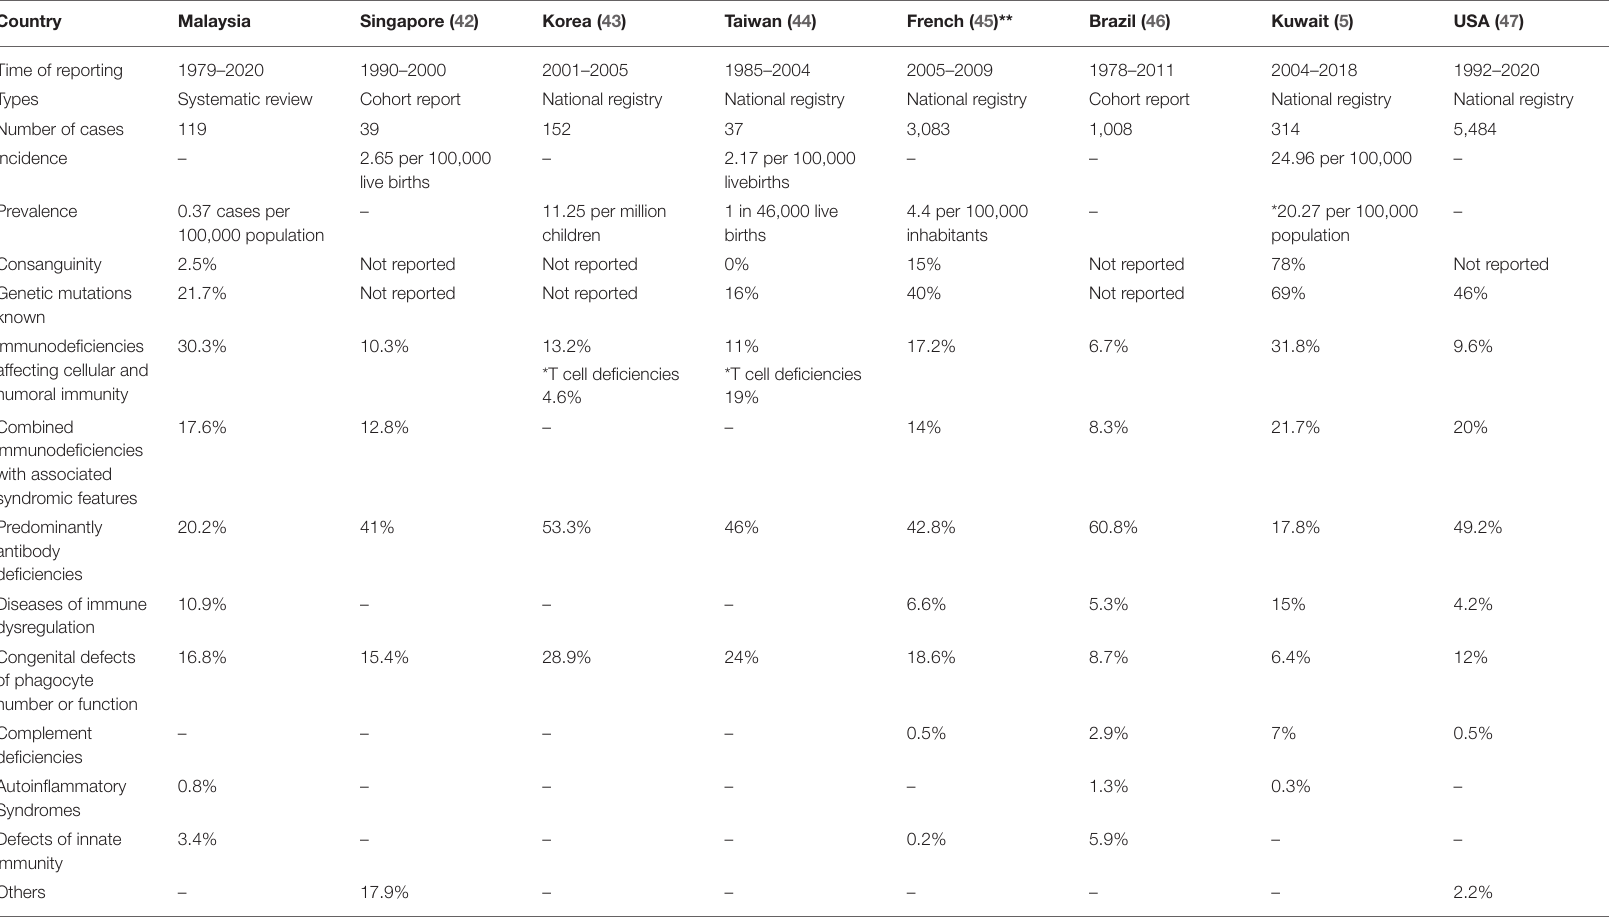
TABLE 4 | The comparison of primary immunodeficiencies prevalence, frequencies, consanguinity, and availability of genetic results with various countries.